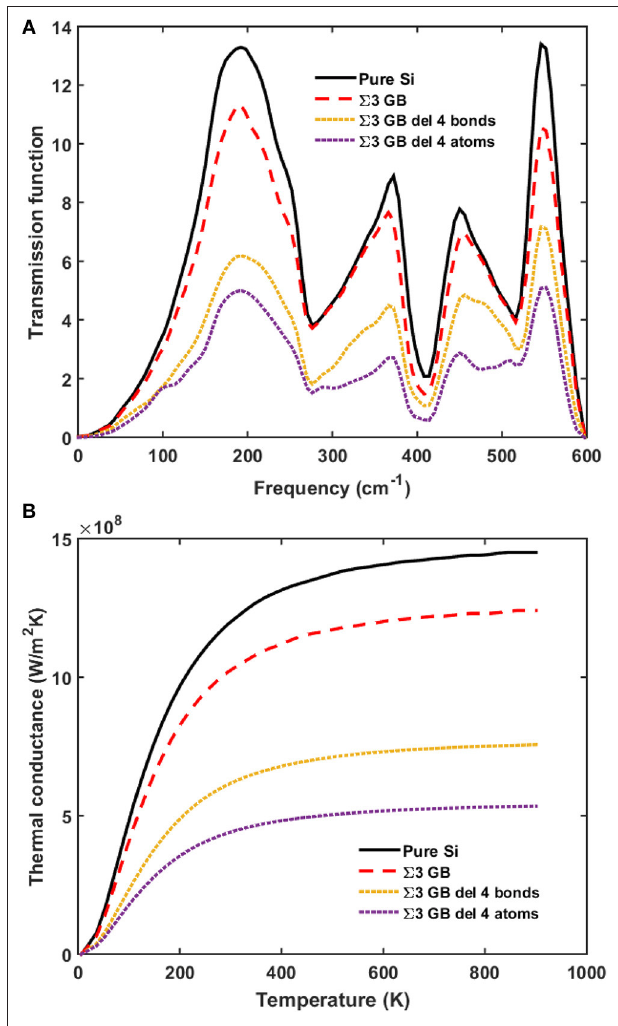
FIGURE 5 | (A) Phonon transmission and (B) thermal conductance for pure silicon (black solid line), silicon with perfect 6 3 grain boundary (red dashed line), and silicon with defective 6 3 grain boundary with dangling bonds (yellow dotted line), and missing atoms (purple dotted